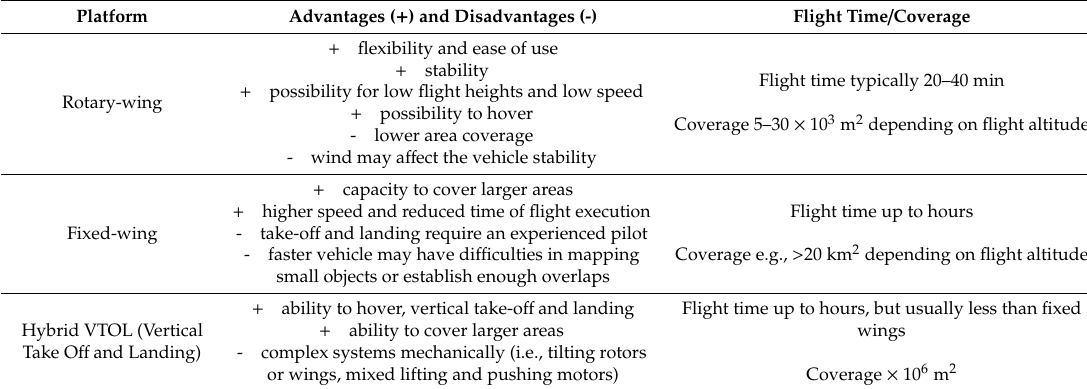
Table 1. (Dis)advantages of di ff erent platforms.